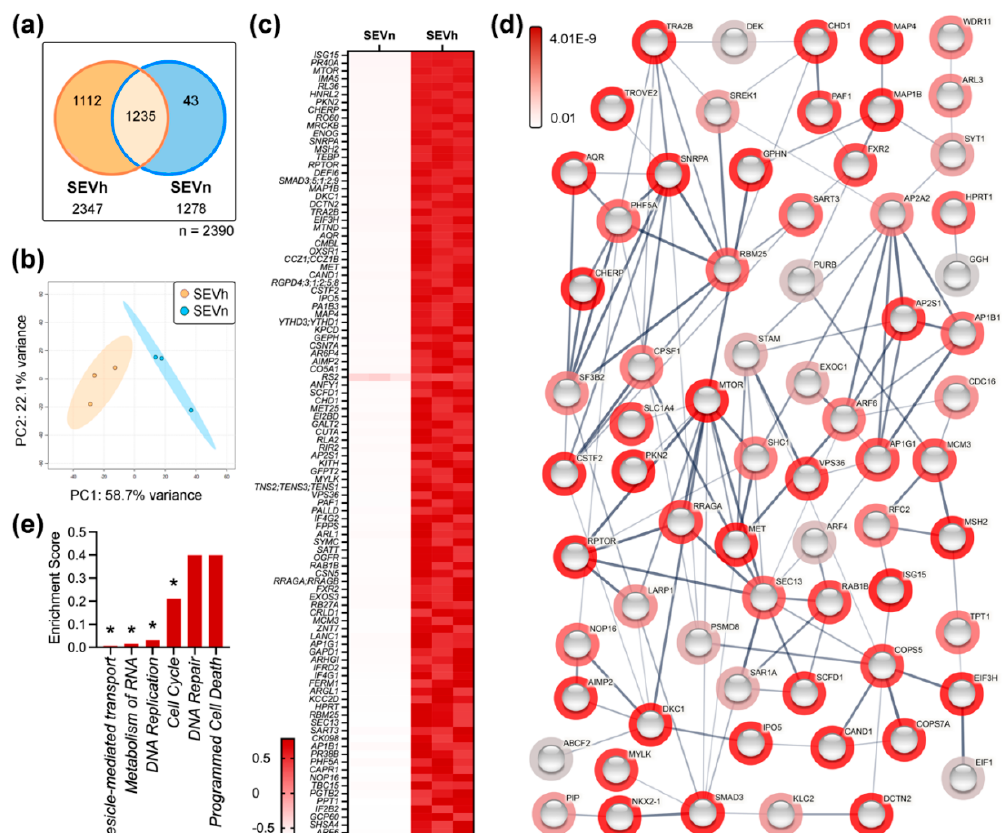
Figure 2. Comparative SEV proteomic profiling. ( a ) Venn diagram of protein distribution in SEV. ( b ) Principal component analysis (PCA) score plot. ( c ) Heatmap of top 100 proteins differentially expressed in SEVh ( p < 0.01). ( d ) Interaction map of top 144 differentially expressed proteins in SEV samples with hidden disconnected nodes, created on String-DB. Halos indicate the strength of p values from the statistical analysis of normalized data (red to gray). Strings are shown as confidence network edges, with soft lines for medium confidence (0.4), regular lines for high confidence (0.7) and bold lines for highest confidence (0.9). ( e ) Enrichment analysis on Reactome indicates the up- regulation of pathways from vesicle-mediated transport, metabolism of RNA, DNA replication, and cell cycle in SEVh compared to SEVn. Lower scores are indicative of higher statistical significance. * p < 0.05.